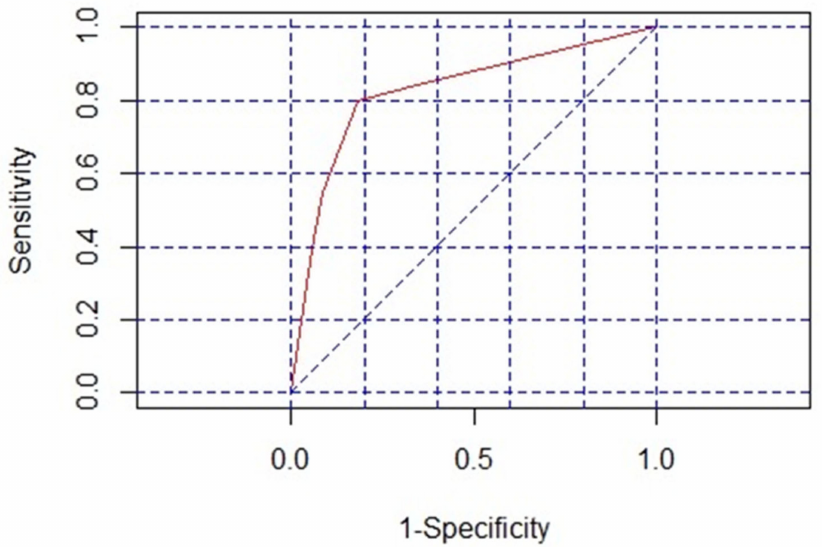
Figure 2. ROC curve (red line) of the scoring model. (blue line: reference line of random